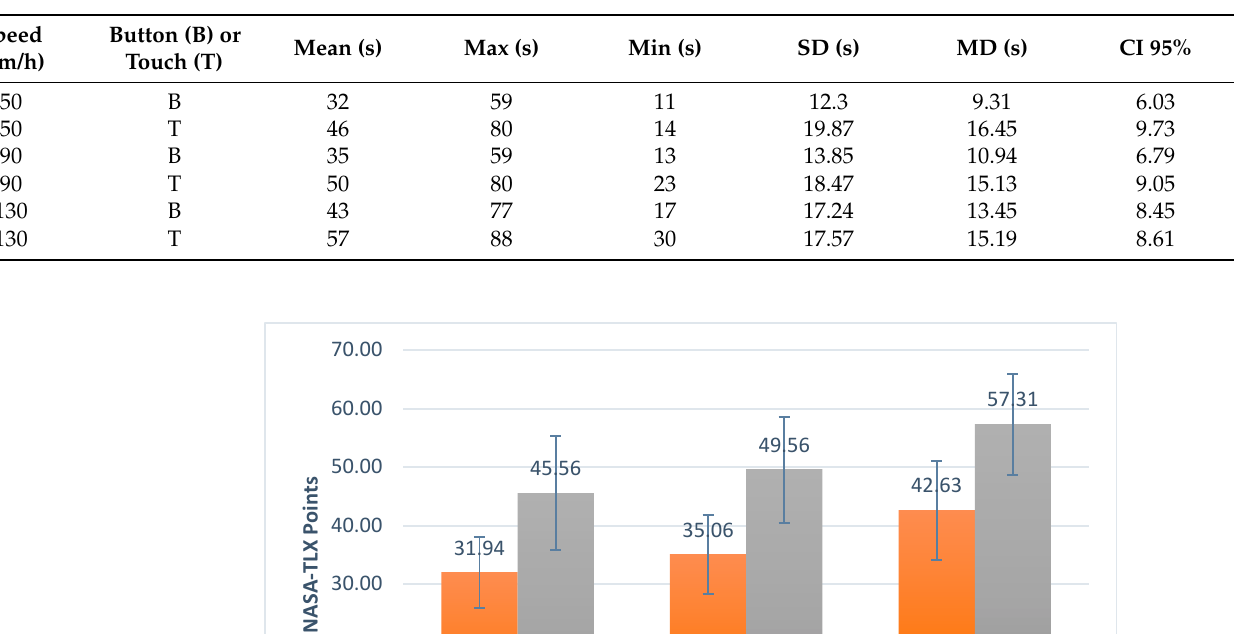
Table 9. NASA-TLX points and statistical values.